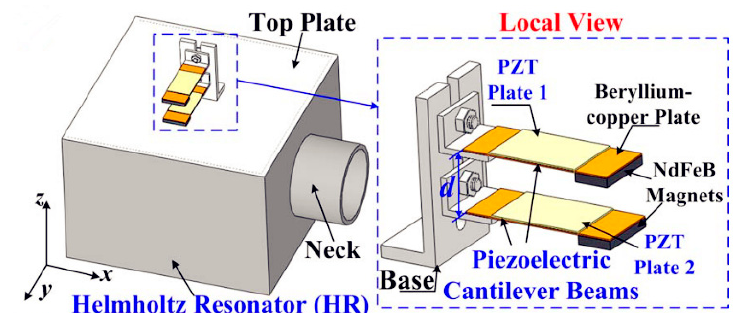
Figure 11. Schematic diagram of the AEH system with strong coupling. Reproduced with permission from [44]; published by American Institute of Physics, 2014.